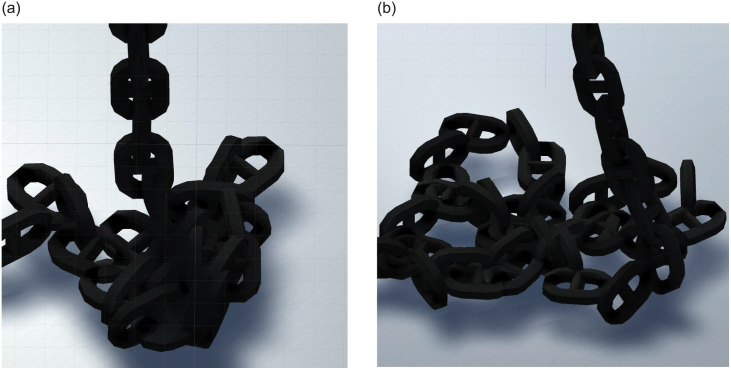
Compression constraint.While kslack = 1, the chain will be more slacker. While kslack = 0, the chain will be more incompressible.